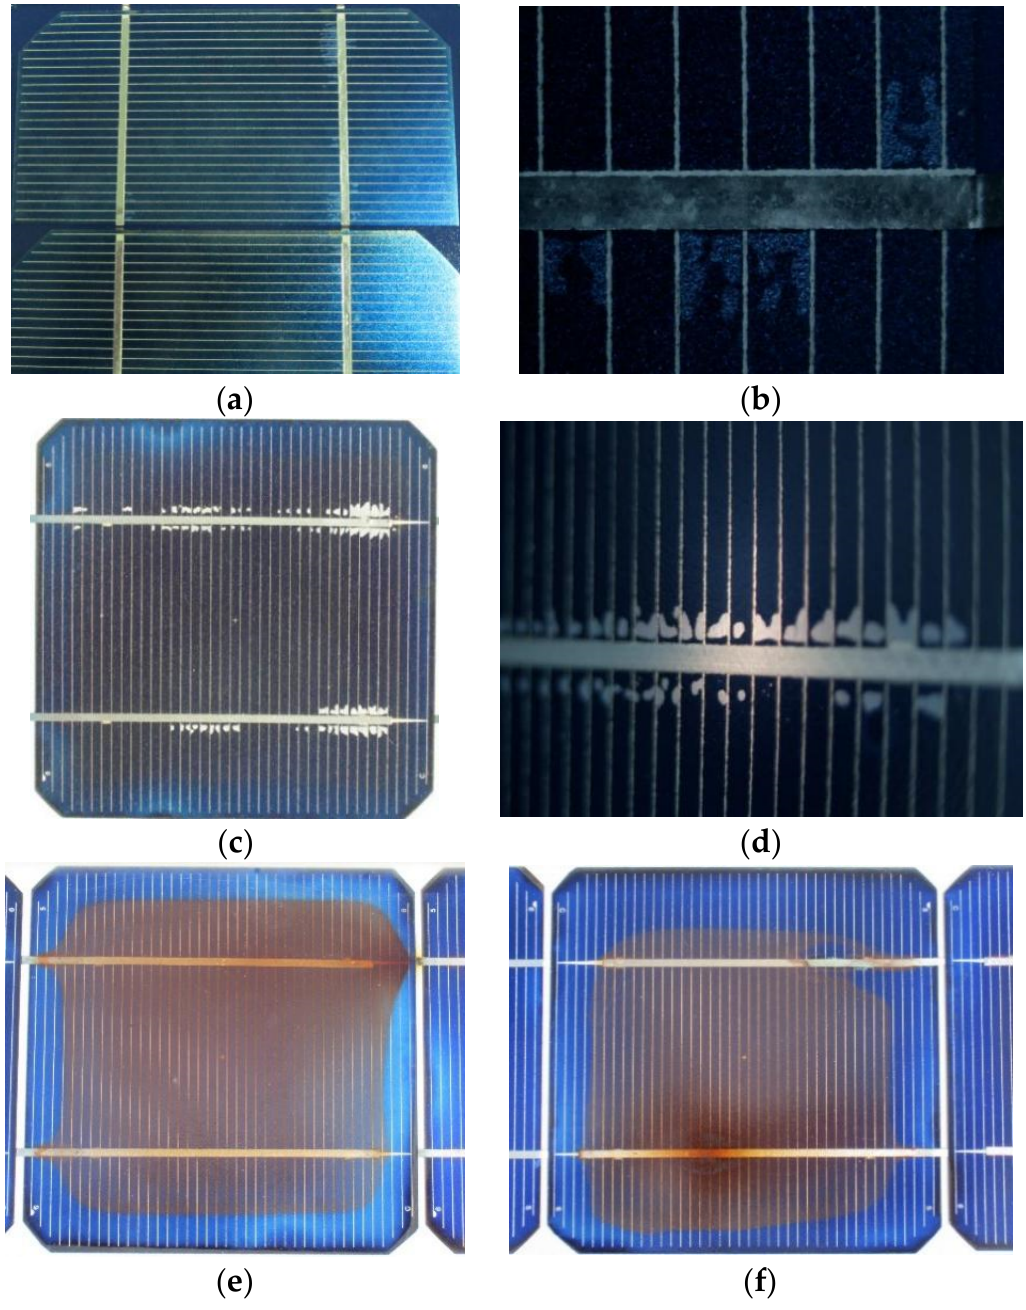
Figure 3. ( a ) Digital image and ( b ) microscopy (20 × ) of c-Si cells of an AP50 module exhibiting early signs of delamination in the EVA/cell interface, ( c ) c-Si cell of an M55 module with extended delamination in the EVA/cell interface along the busbar, ( d ) microscopy (10 × ) of a c-Si cell in the same module showing similar delamination along the busbar, ( e , f ) digital images of M55 cells with severe corrosion on the busbar and interconnect ribbon due to high T c developed there and EVA-molecule